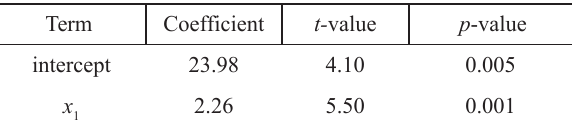
Table 5 – Results of regression analysis for the model pro- posed in Eq. 6 Term